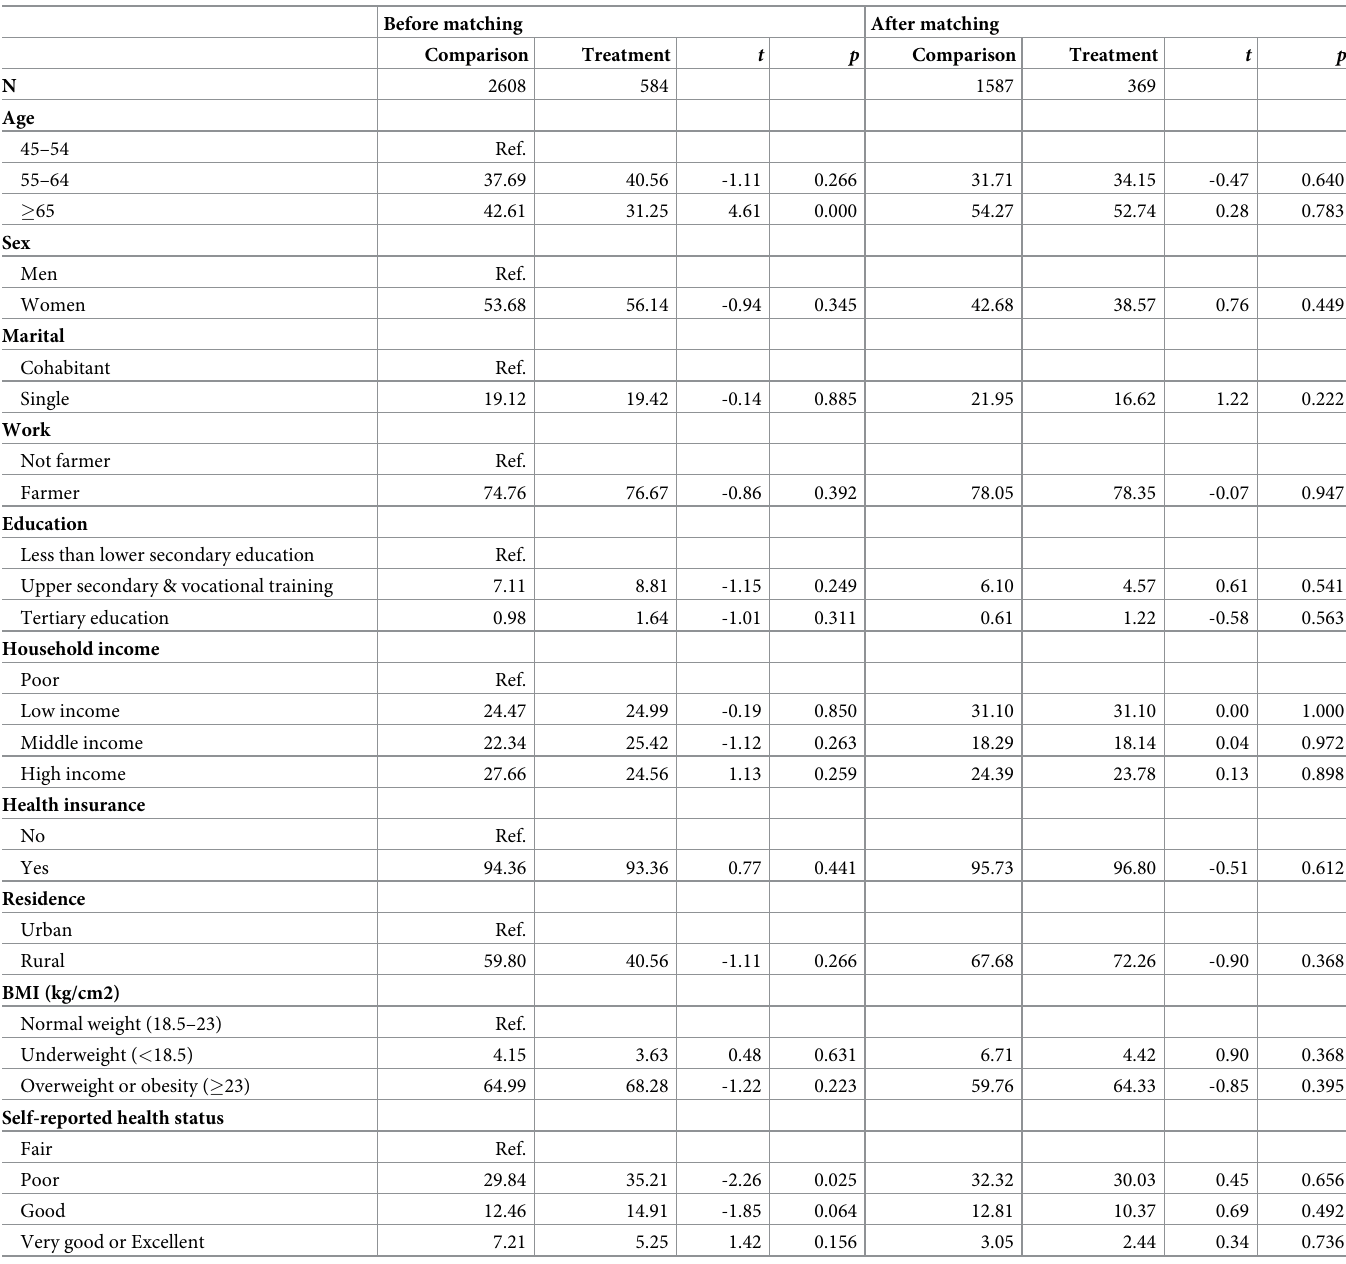
Table 2. Comparable characteristics between the two groups after PSM. Before matching After